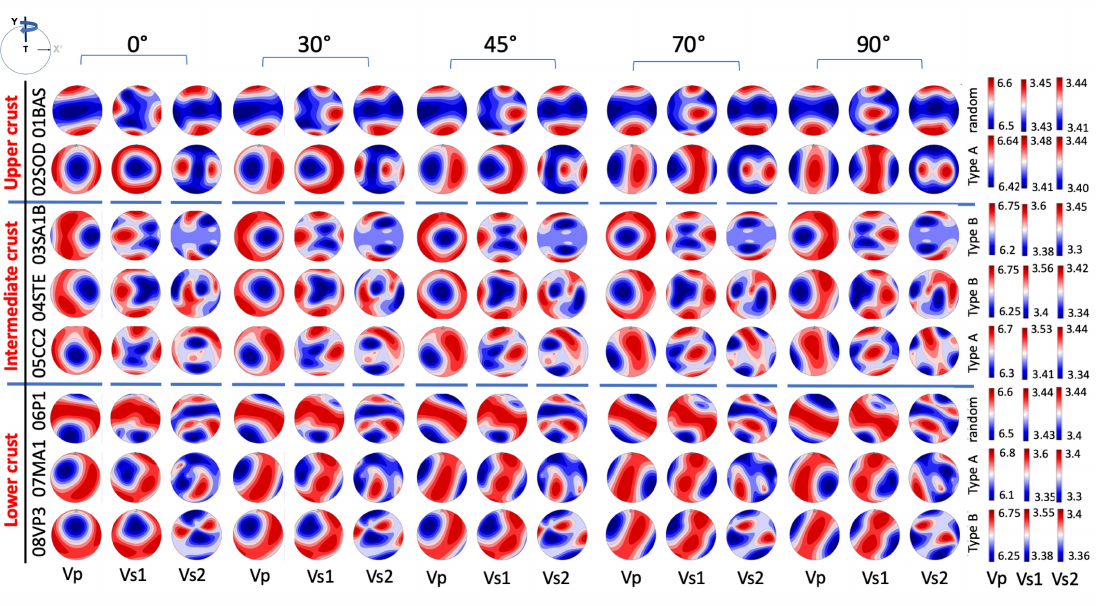
Figure 7. Pole figures representing the P- and S- (S1 and S2) seismic velocities for calcite at different depths and dipping angles to the main macroscopic fabric plane (e.g., shear plane or stratification). X’ corresponds to the horizontal component of the X fabric axis while T corresponds to the normal to the horizontal